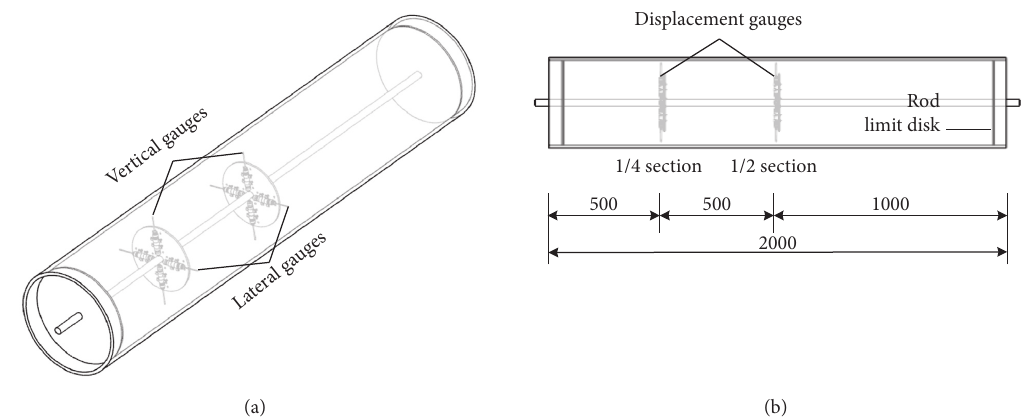
Figure 5: Conduit diameter-change measuring device. (a) Perspective drawing. (b)